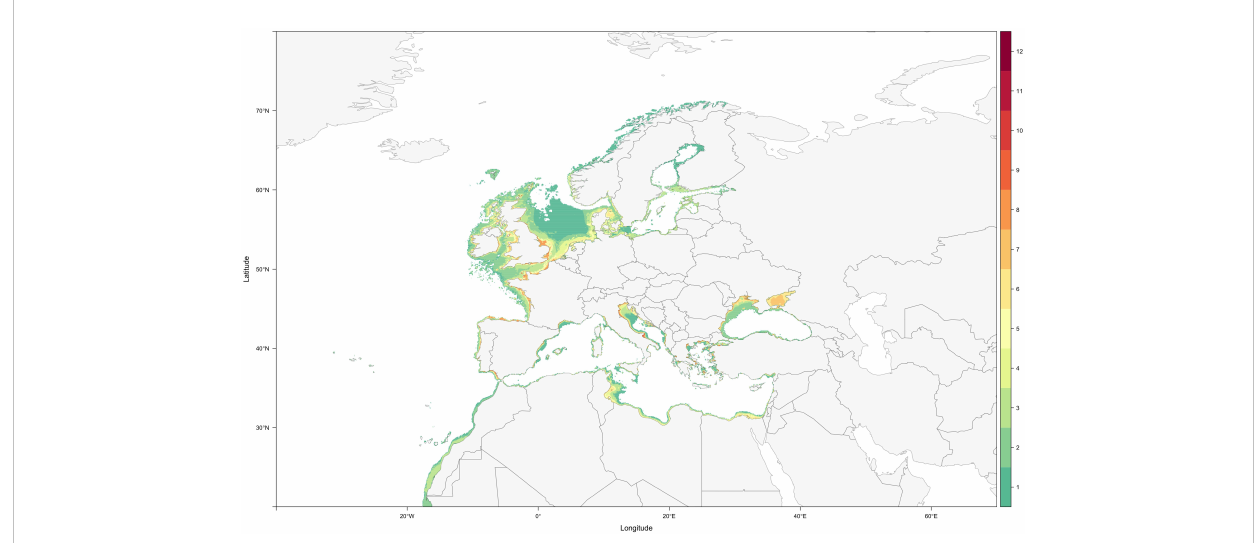
FIGURE 1 Present-day syngnathid diversity along the European coast, resulting from the sum of all nineteen syngnathid ranges (individual ranges derive from IUCN ERMs that were individually corrected for each species ’ depth distribution and maximum distance to the coast; colour scale highlights the number of sympatric